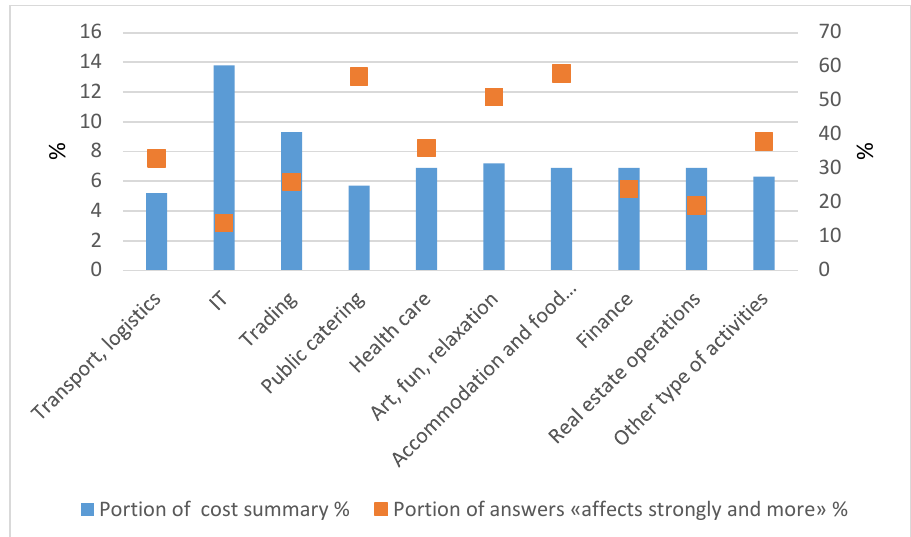
Figure 4. The impact of energy costs in the service sector. Source: personal elaboration.